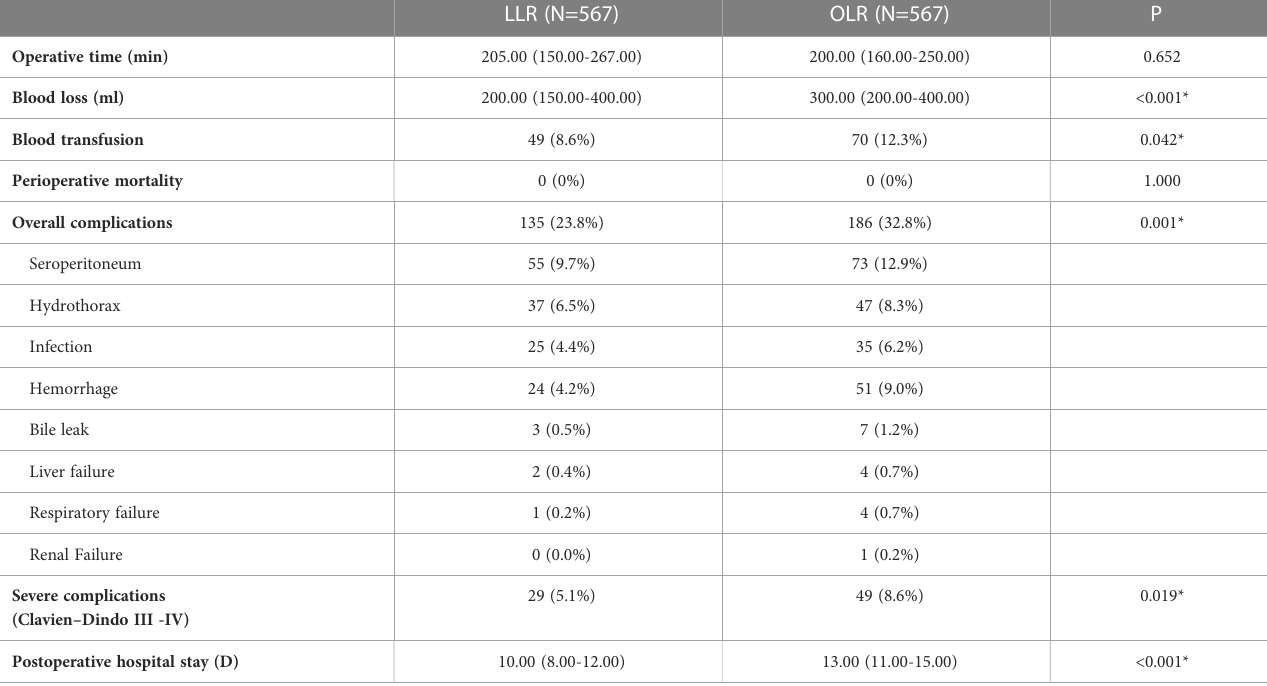
TABLE 2 Operative details and postoperative outcomes between laparoscopic liver resection (LLR) and open liver resection (OLR) groups after propensity score matching.